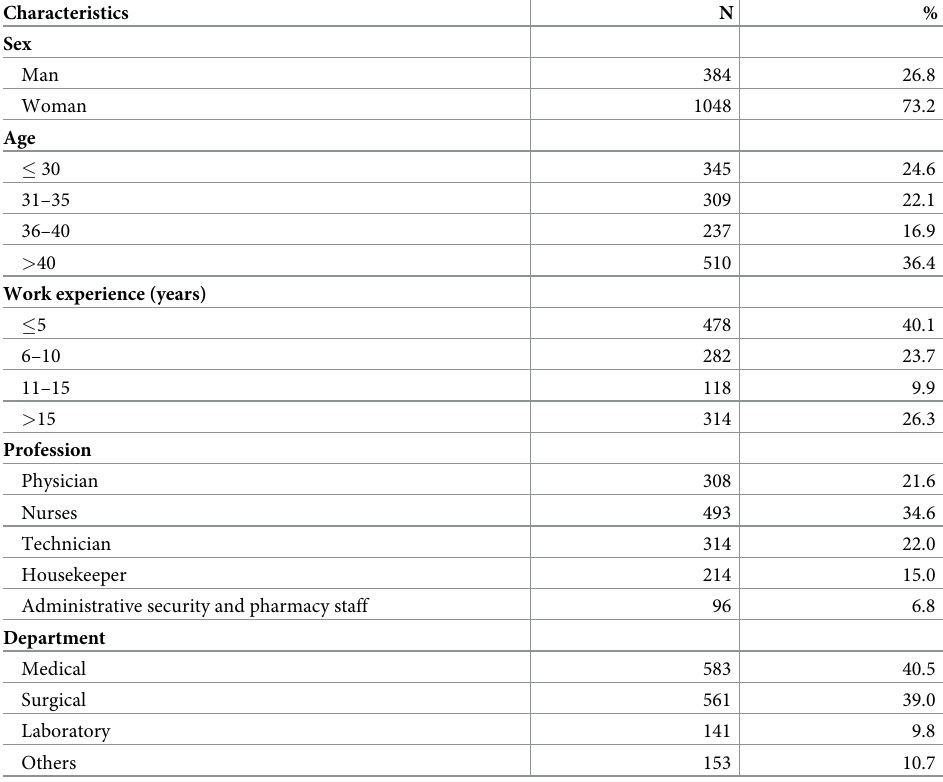
Table 1. Description of sociodemographic characteristics of HCWs of FBUH (Monastir 2017).